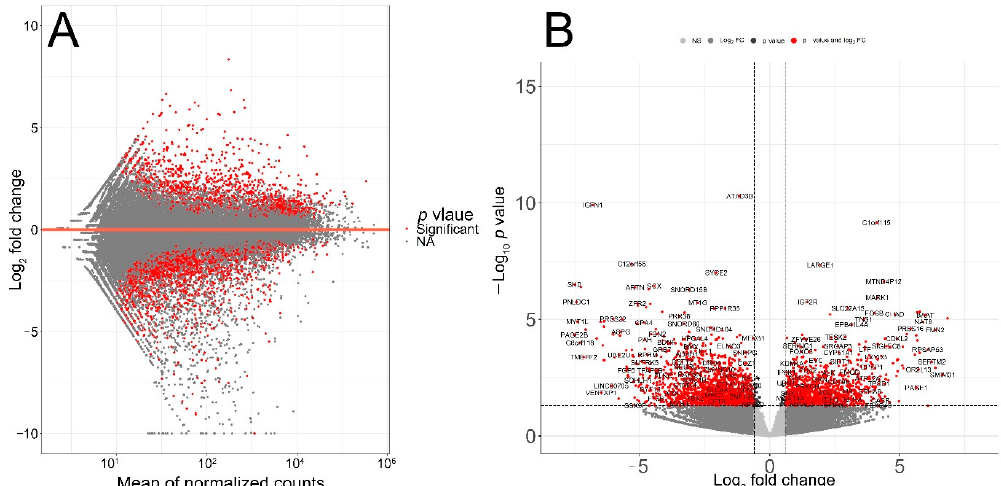
Figure 2. Transcriptomic analysis of TCGA patient’s RNA-seq data. ( A ) MA plot displaying the log 2 fold change compared with the mean of normalized counts generated with DESeq2 package. ( B ) Volcano plot of differentially expressed genes. Direction comparison of young/old: 1345 genes were upregulated and 1767 genes were downregulated. Red: significant; grey: not significant. Right: upregulated; left: downregulated.